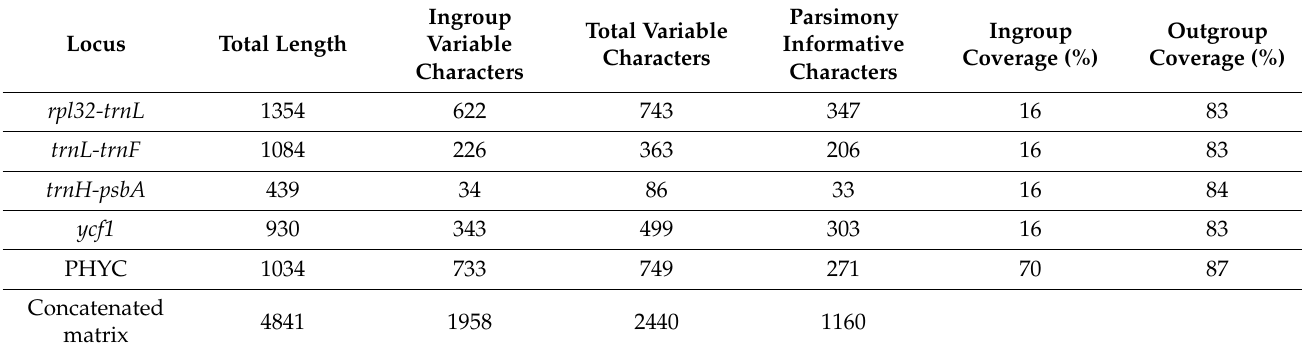
Table 3. Statistics for the 117-sample DNA sequence